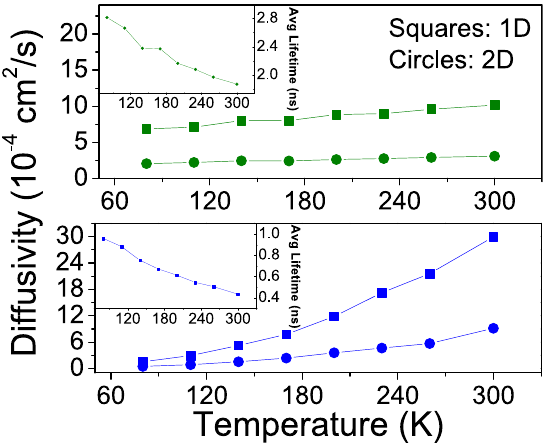
Figure 1. One-dimensional exciton diffusion coefficients as a function of temperature for 6 T (top, green) and P6P (bottom, blue) in the 1D (squares) and 2D (circles) morphologies. Inset: Average exciton lifetimes for different